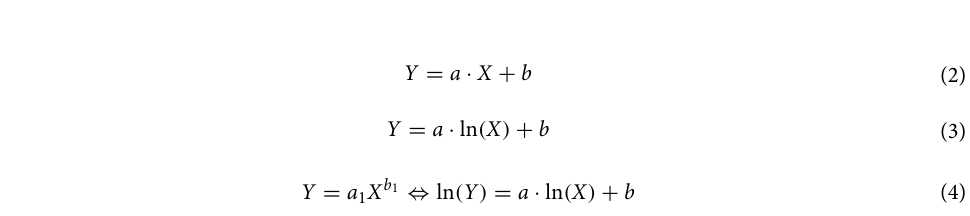
Table 1. Assignment of the analysed absorption bands to chemical moieties embodied in cellulose